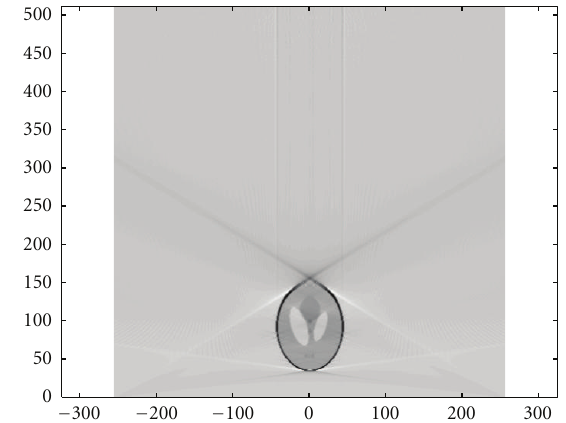
Figure 22: Shepp-Logan phantom.